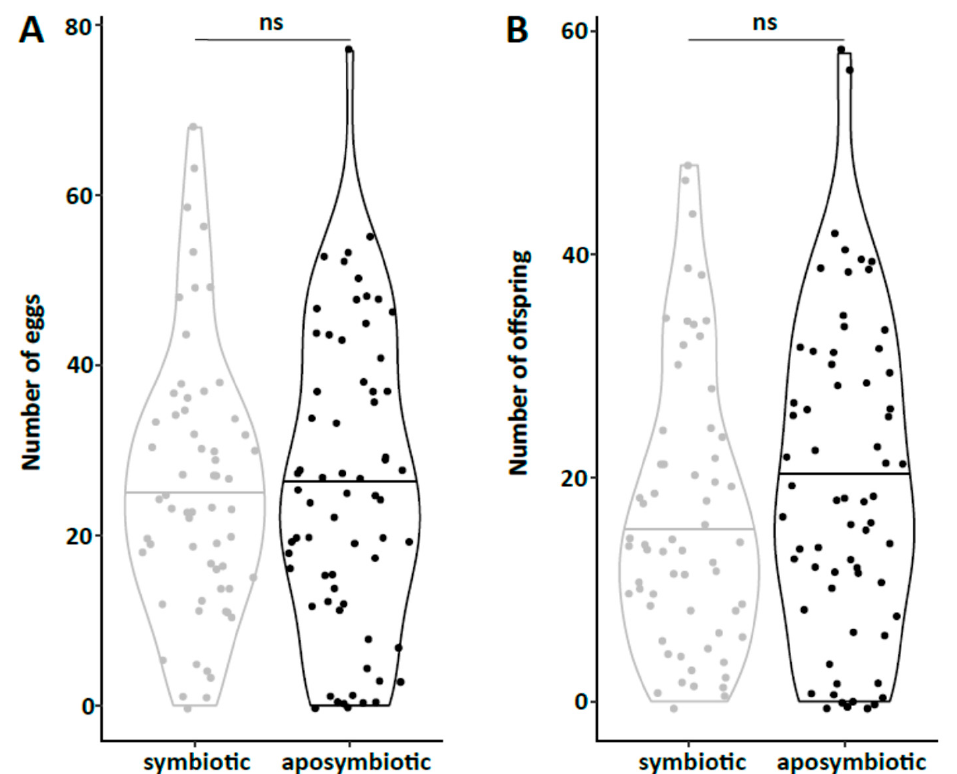
Figure 4. Influence of symbionts on reproductive traits of aposymbiotic (grey contours) and symbiotic (black contours) O. surinamensis females from the JKI-2 experimental lines. Shown is ( A ) the lifetime reproductive output (number of eggs) of a single female and ( B ) the number of offspring from a single female that reached the reproductive (adult) stage. Lines in contours indicate median of the respective sample group. No significant differences were observed using Wilcoxon rank sum test (ns = p > 0.05).